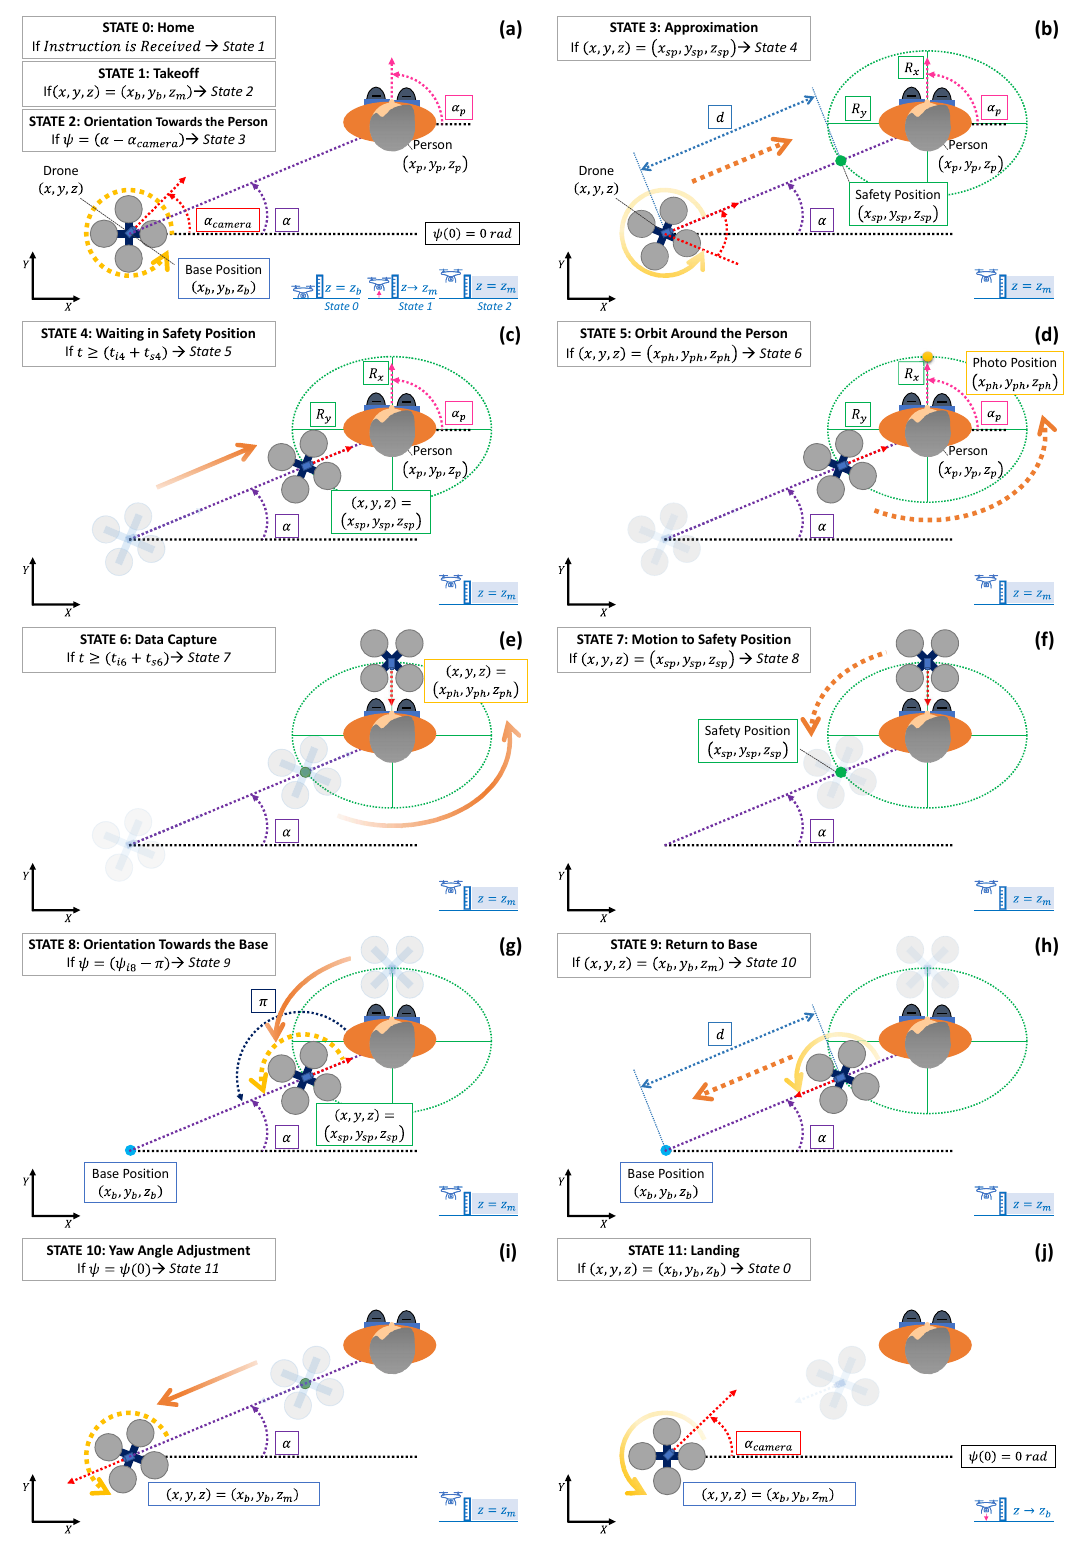
Figure 6. Graphical representation of the trajectory planner’s states: ( a ) states 0—home, 1—takeoff, and 2—orientation towards the person; ( b ) state 3—approximation; ( c ) state 4—waiting in safety position; ( d ) state 5—orbit around the person; ( e ) state 6—data capture; ( f ) state 7—motion to safety position; ( g ) state 8—orientation towards the base; ( h ) state 9—return to base; ( i ) state 10—yaw angle adjustment; ( j ) state